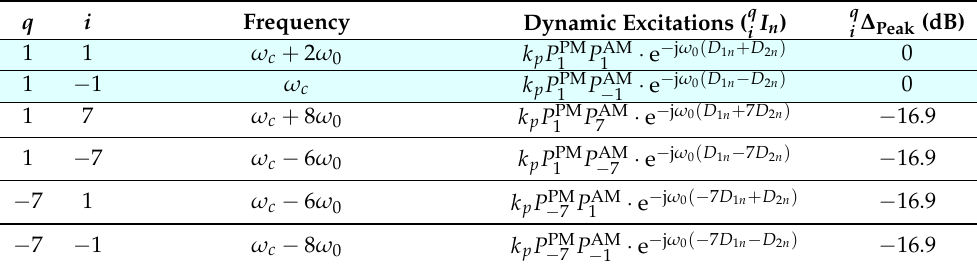
Table 2. Characteristics of the dominant harmonic patterns of Equation (6) in decreasing order of significance for the case of 4-level AM and 8-level PM time-modulating waveforms. The useful harmonics are shaded in light